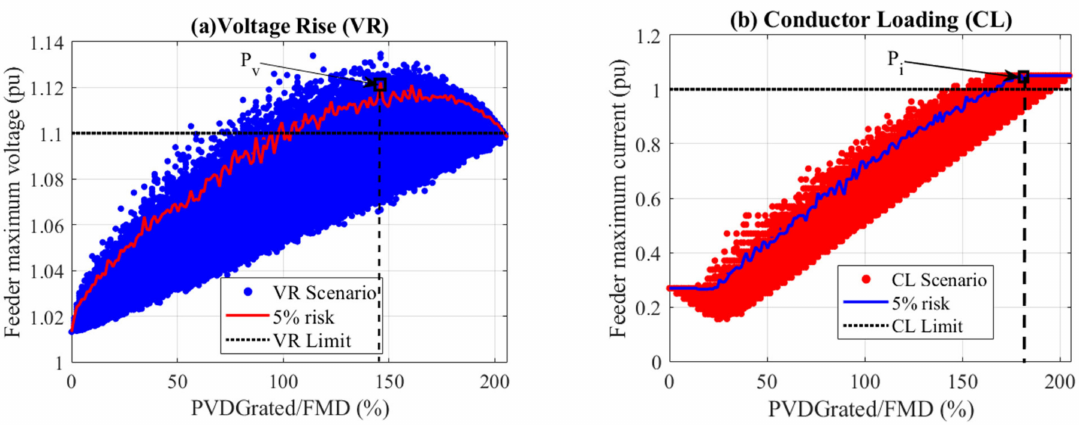
Figure 6. Illustration of the passive feeder response: ( a ) voltage rise ( b ) conductor